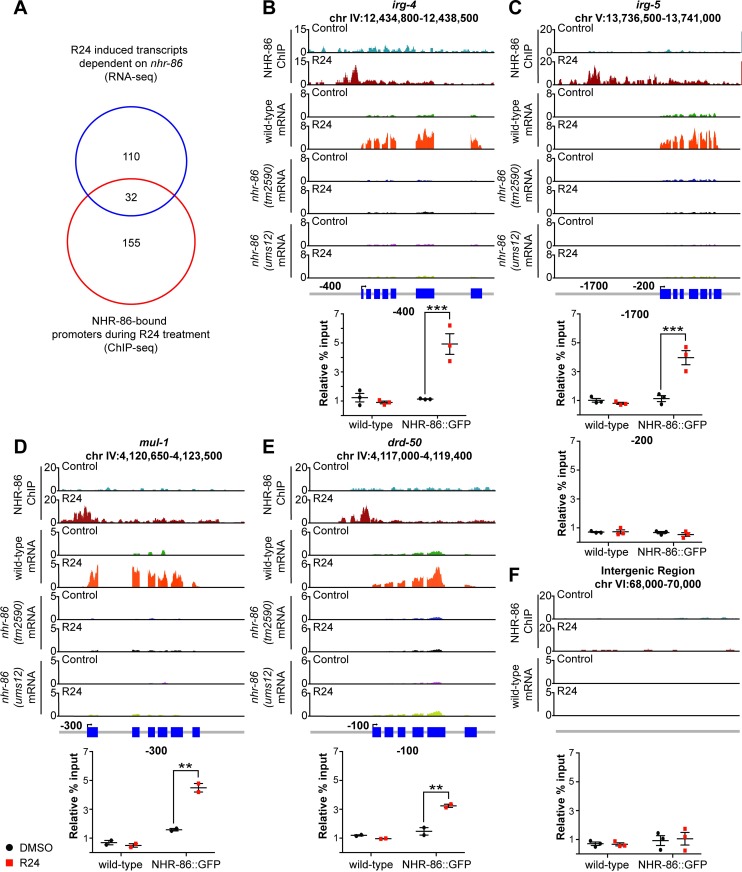
NHR-86 binds to the promoters of innate immune genes to drive their transcription.(A) Venn diagram showing the number of nhr-86-dependent, R24-induced genes in the mRNA-seq experiment, the genes whose promoters were bound by NHR-86 following R24 treatment in the ChIP-seq experiment, and the overlap between these datasets. The overlap between these datasets is significantly more than is expected by chance alone (1.1 gene overlap expected by chance, hypergeometric p-value = 2x10-39). ChIP-seq profiles, mRNA-seq profiles and confirmatory ChIP-PCR are presented for the representative immune effectors irg-4
(B),
irg-5
(C),
mul-1 (F49F1.6) (D) and drd-50 (F49F1.1) (E) in animals of the indicated genotype exposed to R24 or the control. The y-axis is the number of reads (log2). A gene model shows the location of the exons (blue) of the indicated genes. ChIP was performed with an anti-GFP antibody in C. elegans wild-type and transgenic NHR-86::GFP animals. Final set of peaks were called if the difference in intensity values of samples had a significance level of p-value < 0.025 (see S3 Table) for the indicated comparison. In the ChIP-PCR data, the percent input for each condition was normalized to the abundance of a random intergenic region of chromosome four. ** p<0.01 and *** p<0.001 by 2-way ANOVA with Bonferroni multiple comparisons test for the indicated comparison. A region 200 bp upstream of irg-5
(C) and a random intergenic region on chromosome six (F) were not enriched by control or R24 treatment. Each data point in the ChIP-qPCR data is from an independent biological replicate.